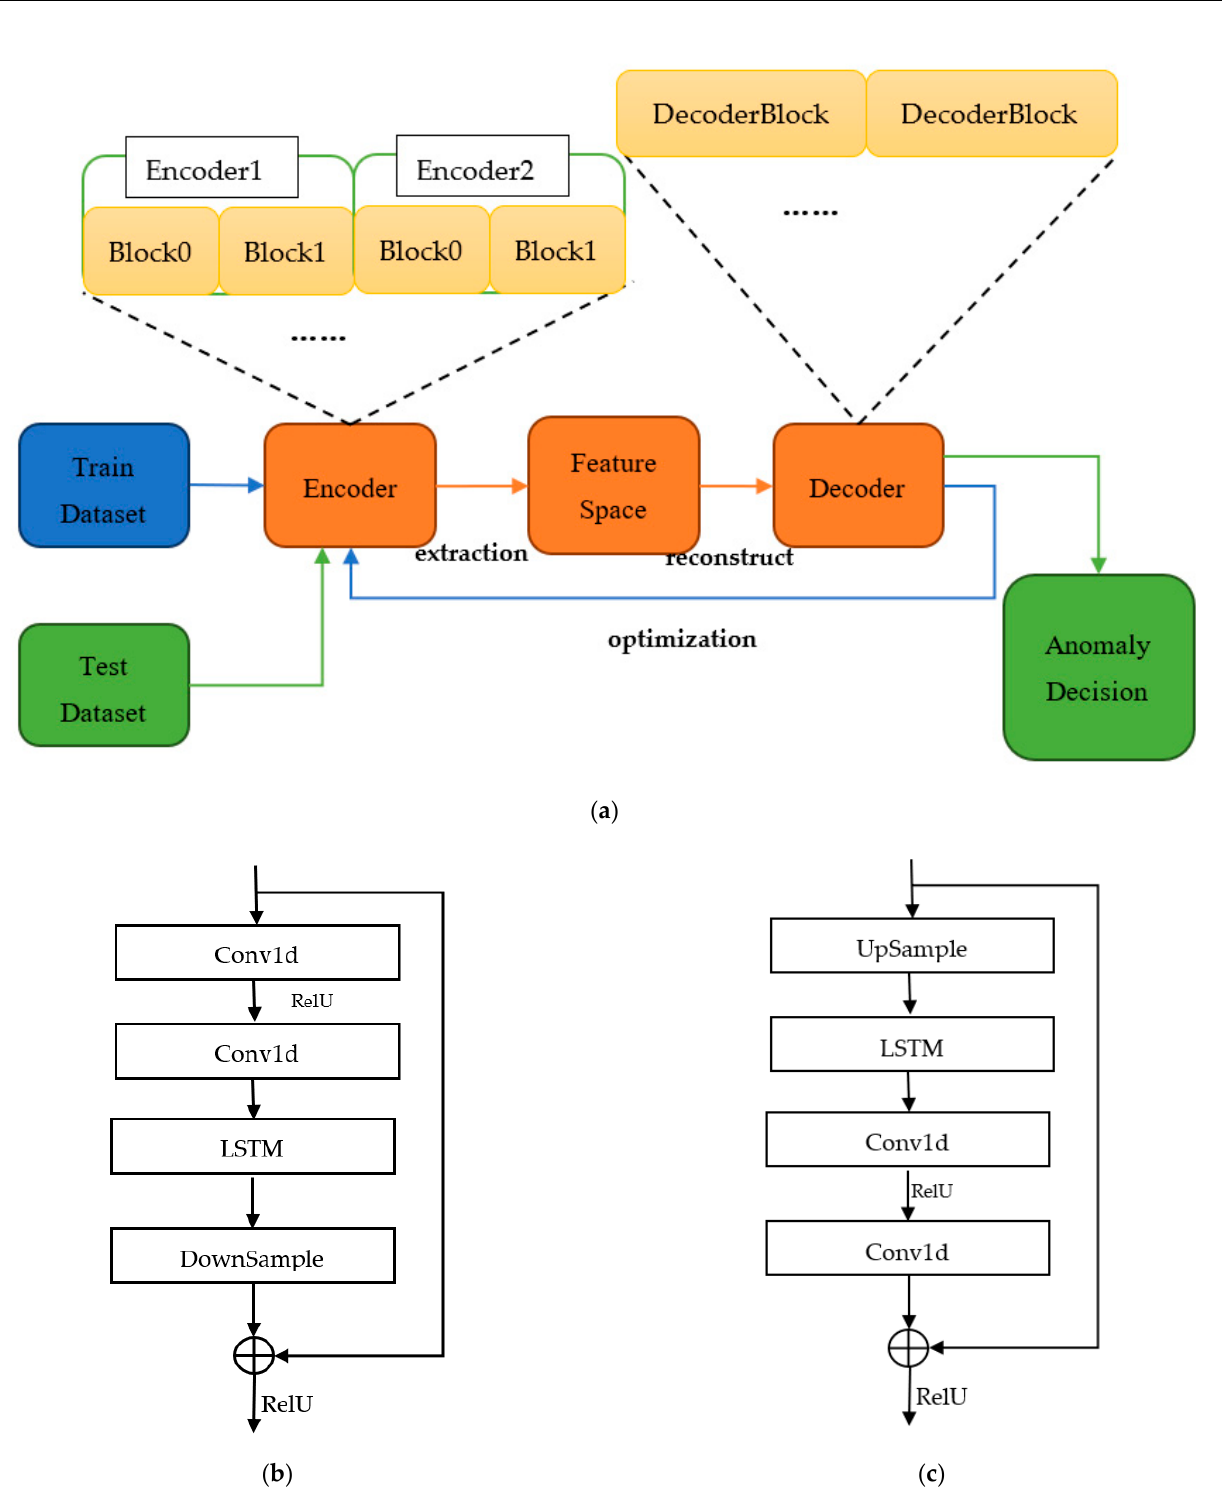
Figure 2. ResNet-AE network structure: ( a ) Overall structure; ( b ) Encoder residual structure; ( c ) Decoder residual structure.